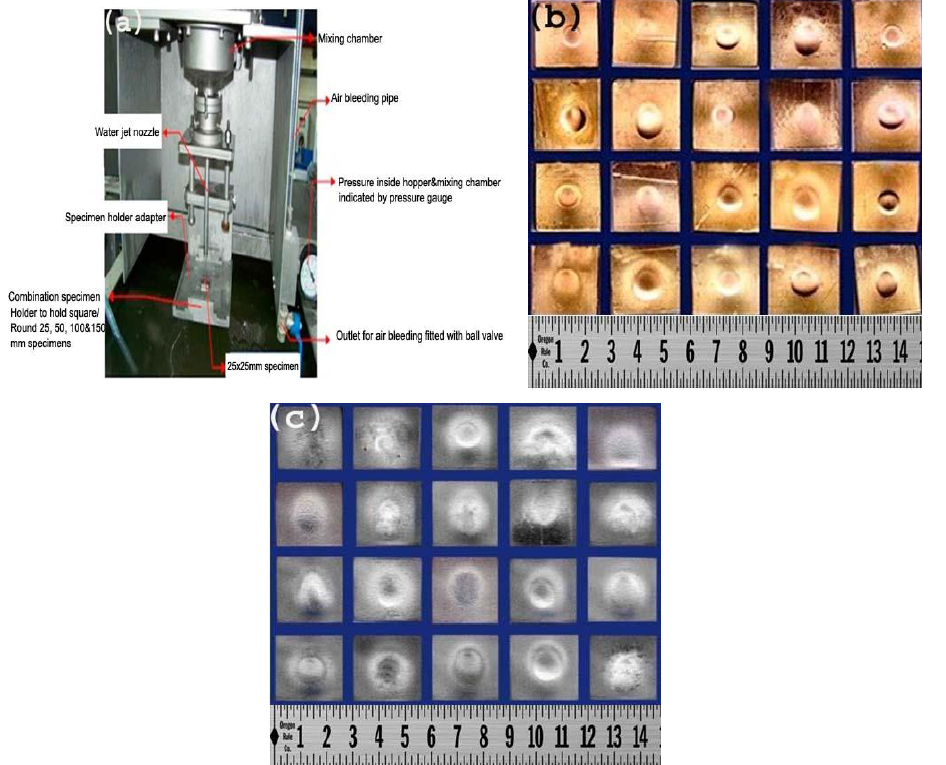
Figure 4. Photographs of water jet erosion specimens before and after the test: ( a ) water jet erosion test setup; ( b ) uncoated specimens after the test; ( c ) coated specimens after the test.